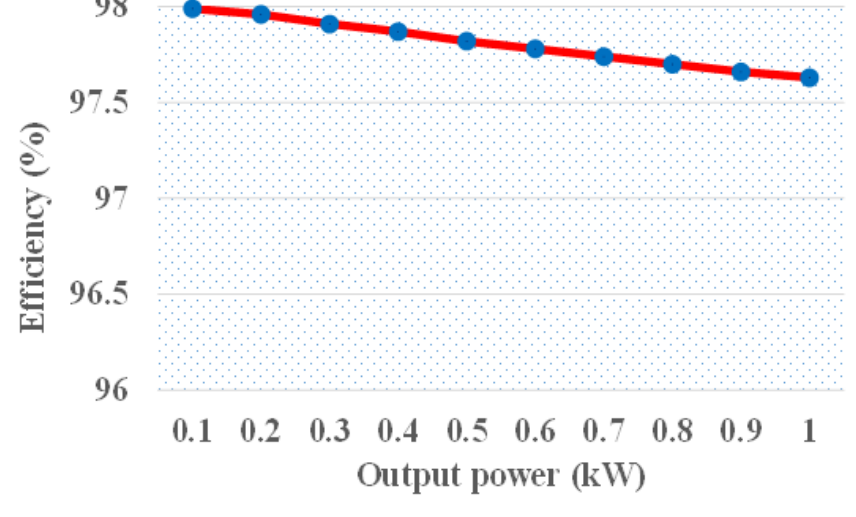
Figure 4. Efficiency curve.